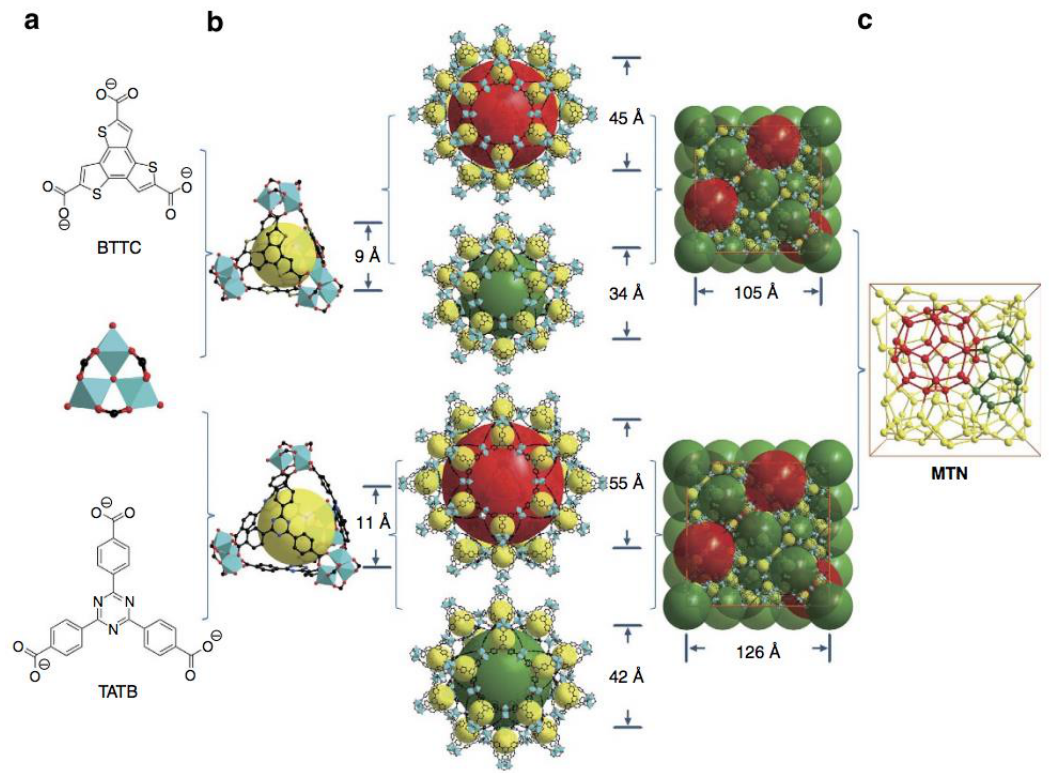
Figure 9. ( a ) representations of linkers and SBU used in the construction of PCN-332 and PCN-333, ( b ) cage types ( c ) representation of mtn topology [78]. Adapted from ref. [78] with permission. PCN-333(Al) displayed record loadings for all three enzymes with loadings close to 1 g enzyme/g MOF. HRP is sufficiently large to only be located within the largest cavity,